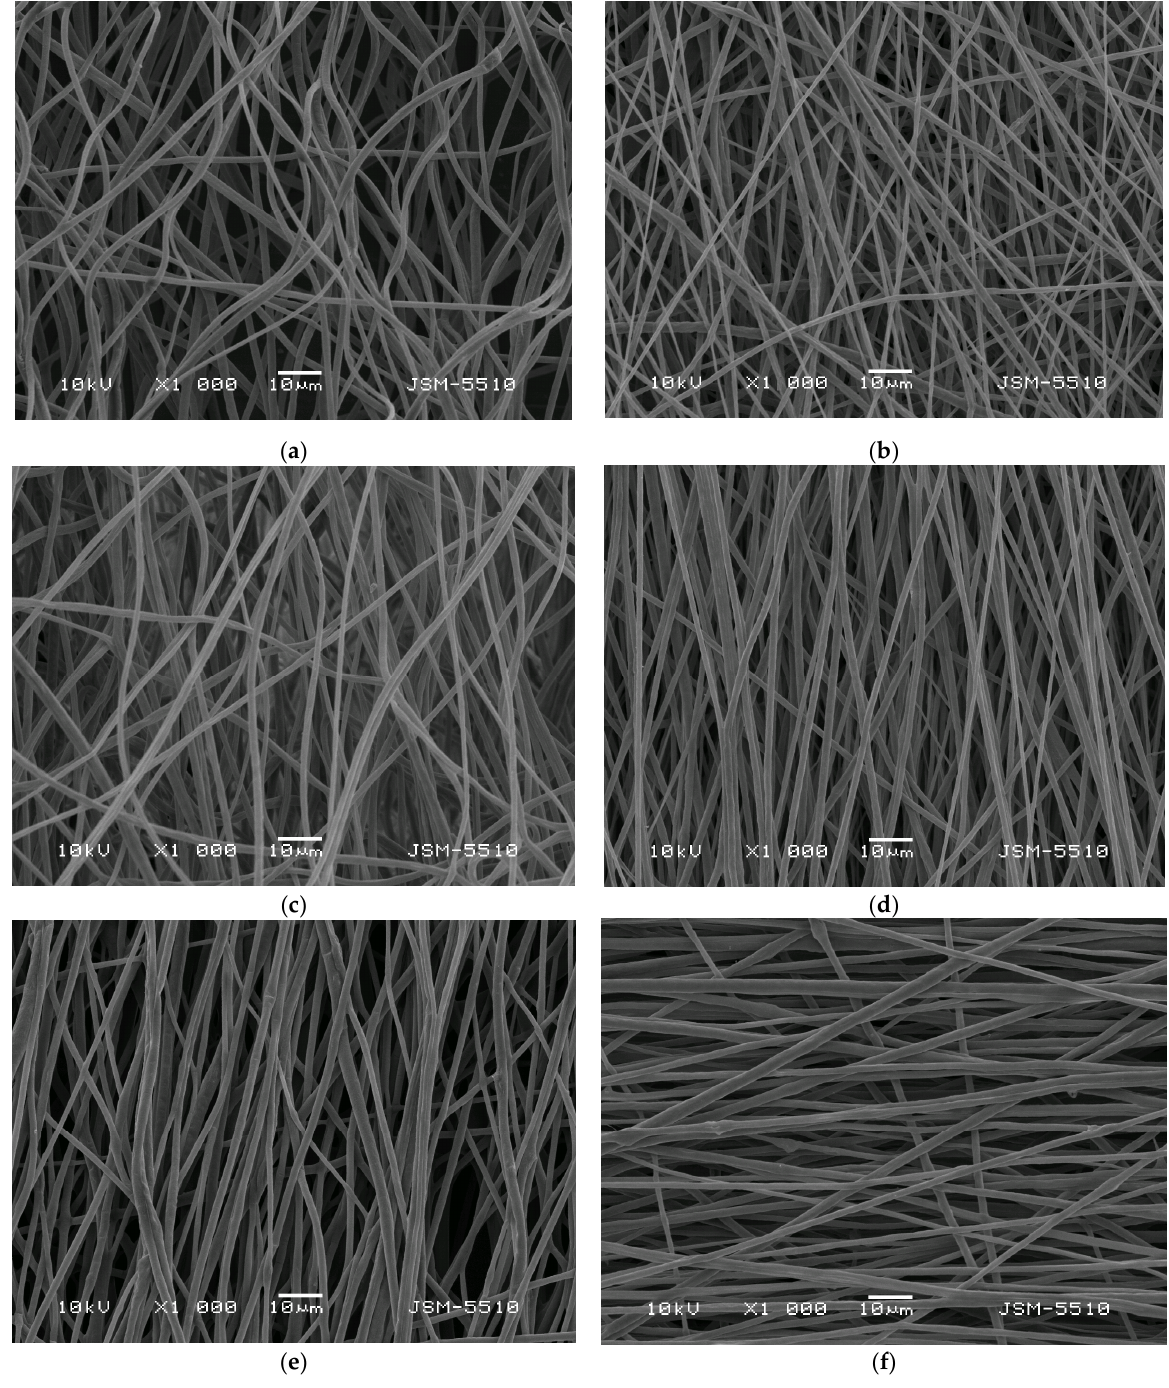
Figure 2. SEM images of fibrous mats based on: ( a ) PLA, ( b ) PLA/PEG, ( c ) PLA/ M. officinalis (5 wt%) ; ( d ) PLA/PEG/ M. officinalis (5 wt%) , ( e ) PLA/ M. officinalis (10 wt%) and ( f ) PLA /PEG/ M. officinalis (10